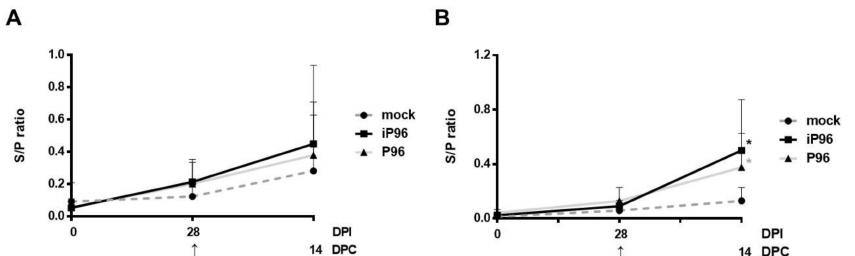
Figure 6. The mucosal immunity of piglets induced by the iPEDVPT-P96 virus ( (cid:4) ), the PEDVPT-P96 virus ( (cid:78) ), or mock-inoculated ( ) at 0 and 28 days post-inoculation (DPI) and at 14 days post-challenge (DPC), after re-challenge or challenge with the PEDVPT-P5 virus. Each group consisted of 5 piglets. The mean S/P ratios of fecal ( A ), and salivary ( B ) anti-PEDV spike IgA in each group at a given time point were generated from the original optical density (OD) values using an in-house PEDV-Spike based indirect ELISA. The error bars indicate standard deviation. The arrow indicated the time point (28 DPI or 0 DPC) of challenge with PEDVPT-P5 virus. Statistically significant differences between each group were examined using a two-way ANOVA by time. Significant differences from the mock group are labeled with asterisks ( p < 0.05).